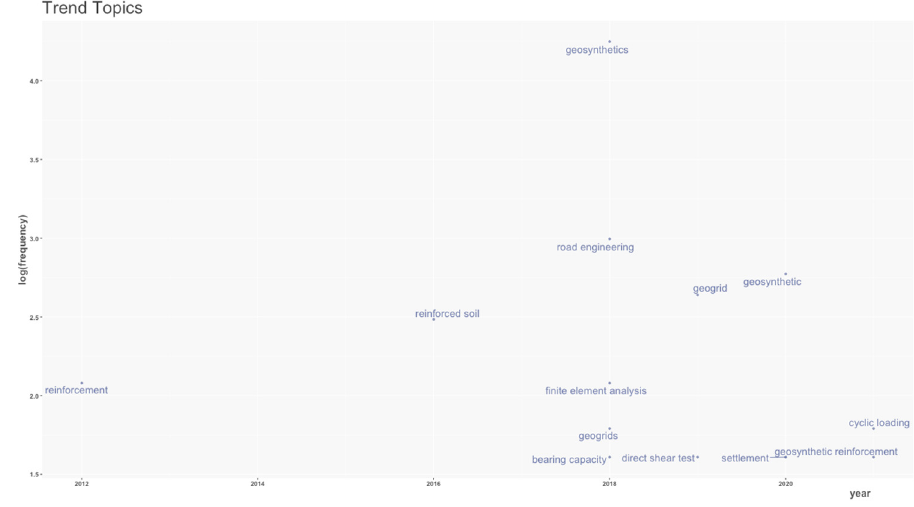
Figure 26. Trend